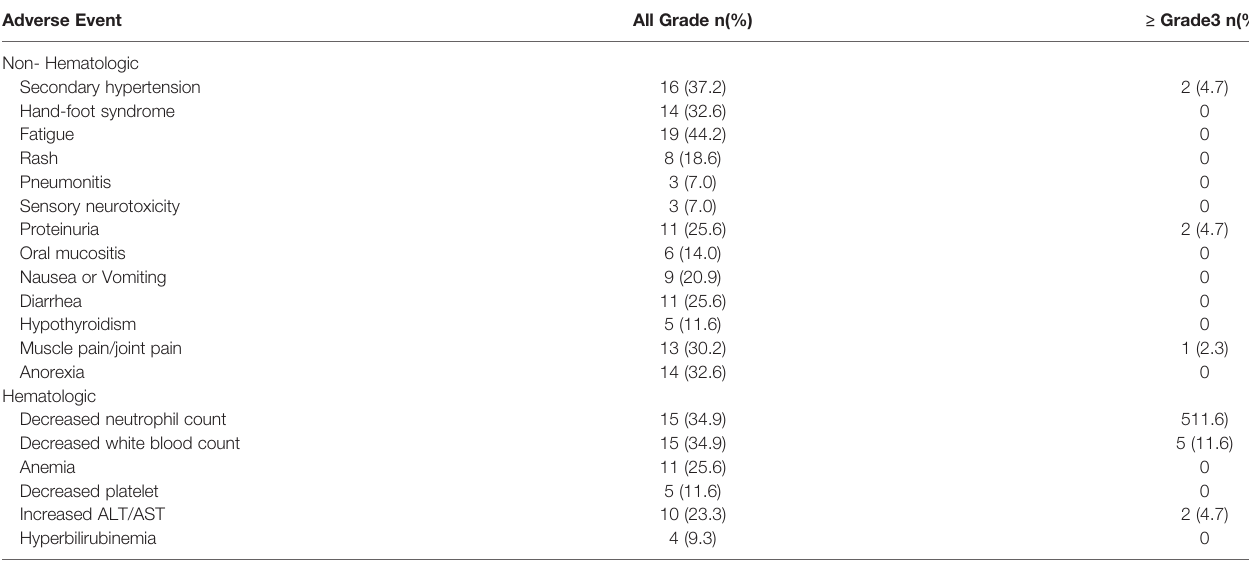
TABLE 3 | Treatment-related adverse events